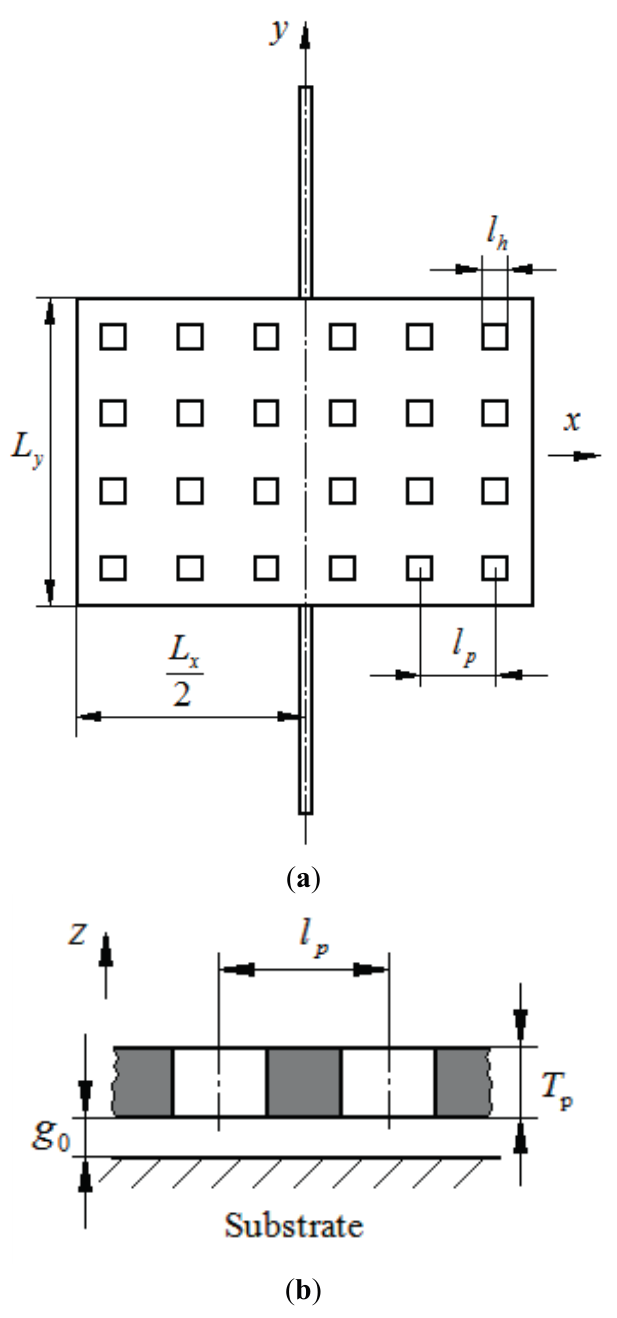
Figure 2. A schematic drawing of a perforated torsion microplate (Type I). ( a ) Top view of the perforated microplate with uniformly distributed holes; ( b ) cross-sectional